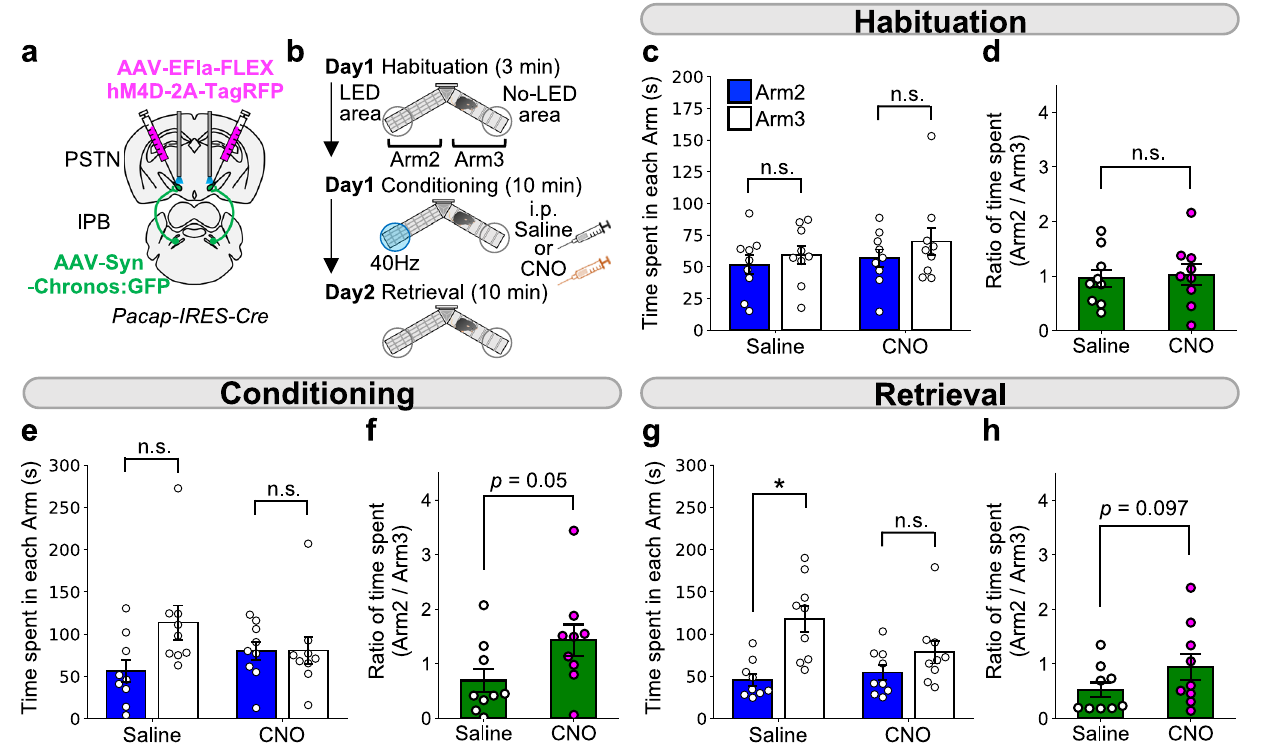
Fig. 9 | Inhibition of PACAP PSTN attenuated effects of the lPB-PSTN pathway. a Schematic of microinjection and placement of the LED cannula unit. b Experimental schedule of the real-time place aversion test using C57BL/6J mice. Saline or CNO was injected 30min before the conditioning session. c – h Summary